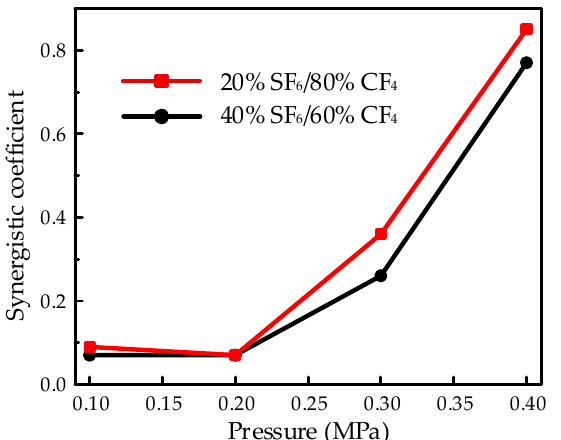
Figure 9. Relation between the synergistic coefficient and pressure with a needle-plate electrode system.